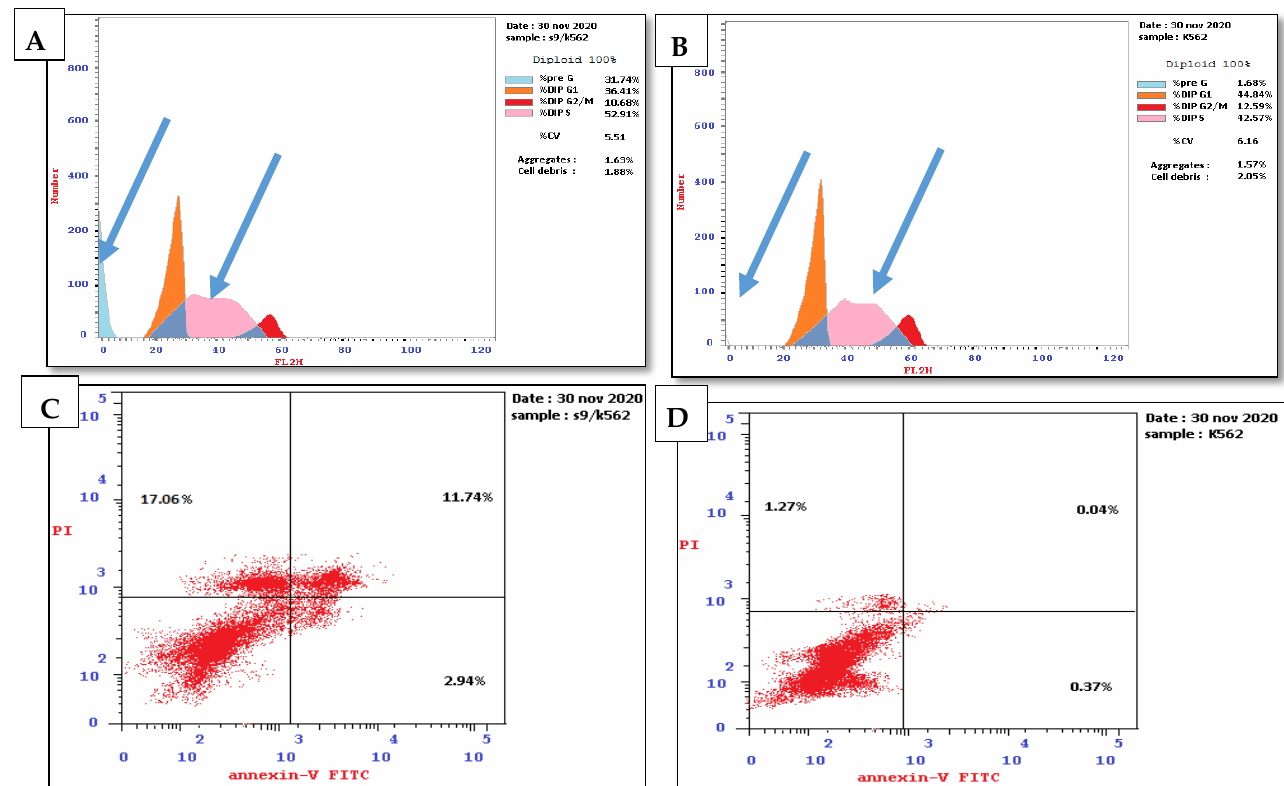
Figure 5. ( A ) Effect of compound 5 on the cell cycle of leukemia cell line K562. ( B ) Untreated cells were used as negative control. ( C ) Apoptosis induced by compound 5 using leukemia cell line. ( D ) Apoptosis of untreated cells as negative control. The four quadrants identified as: lower left: viable cells; lower right: early apoptotic cells; upper right: late apoptotic cells; upper left: necrotic cells.